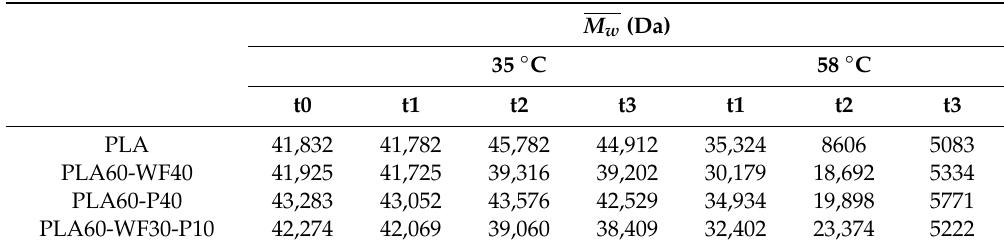
Table 2. Exclusion Chromatography (SEC) results for PLA-based samples after composting tests at 35 ◦ C and 58 ◦ C. M w (Da) 35 ◦ C 58 ◦ C t0 t1 t2 t3 t1 t2 t3 PLA 41,832 41,782 45,782 44,912 35,324 5083 PLA60-P40 43,283 PLA60-WF30-P10 42,274 42,069 39,060 38,409 32,402 23,374